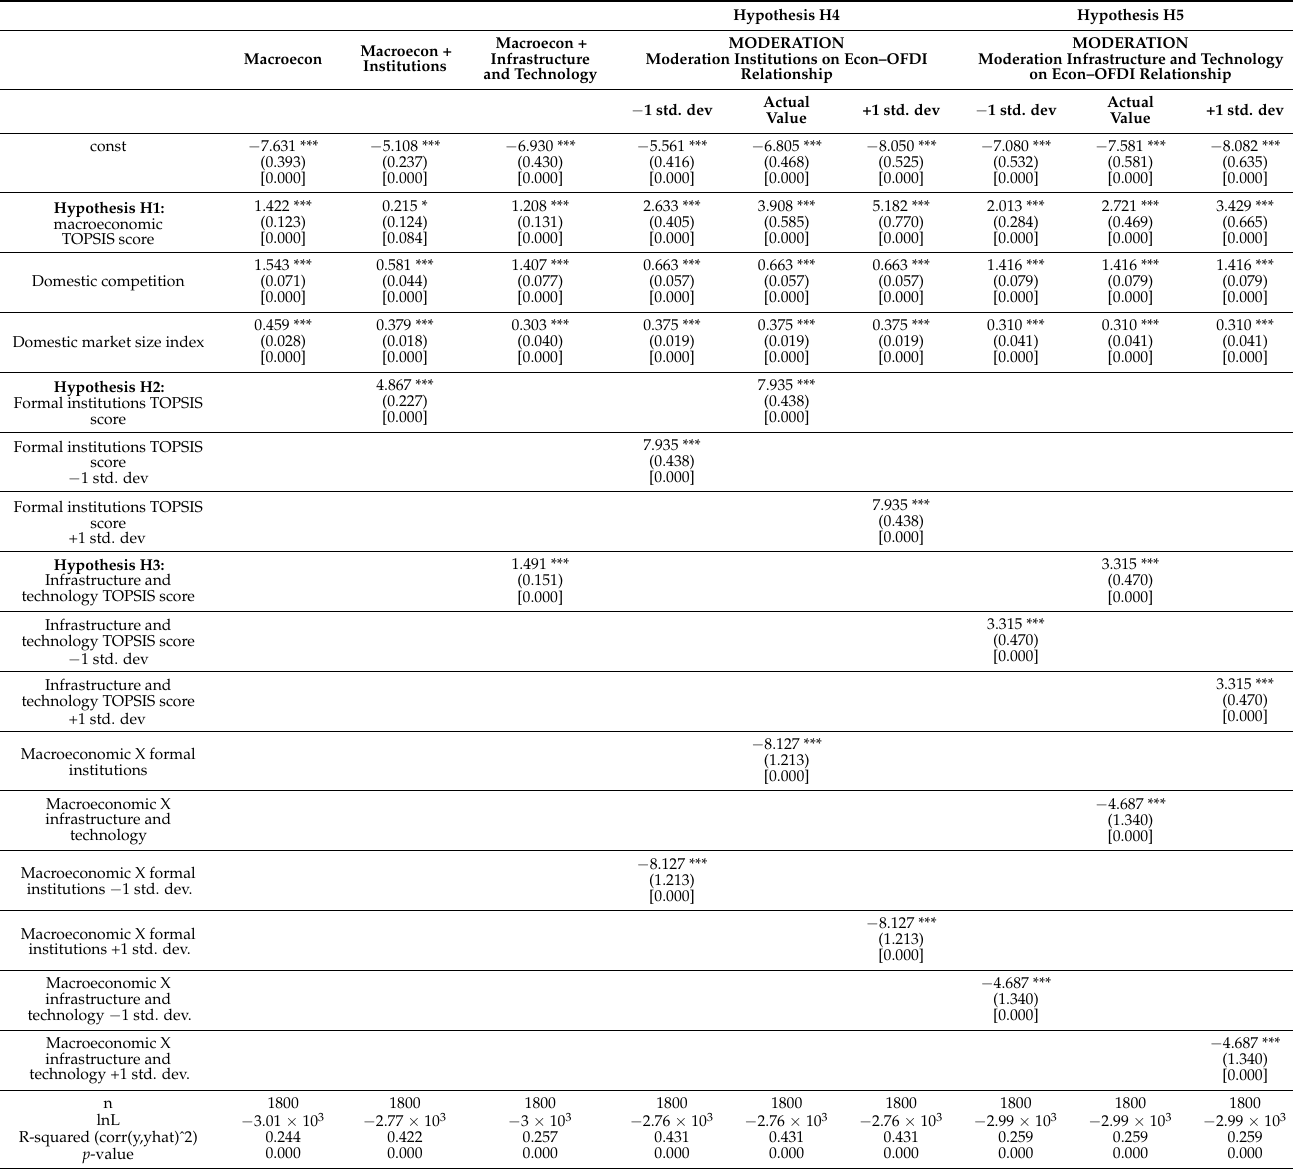
Table 4. The determinants of OFDIs in Latin America. Random-effects (GLS) estimates. Dependent variable: